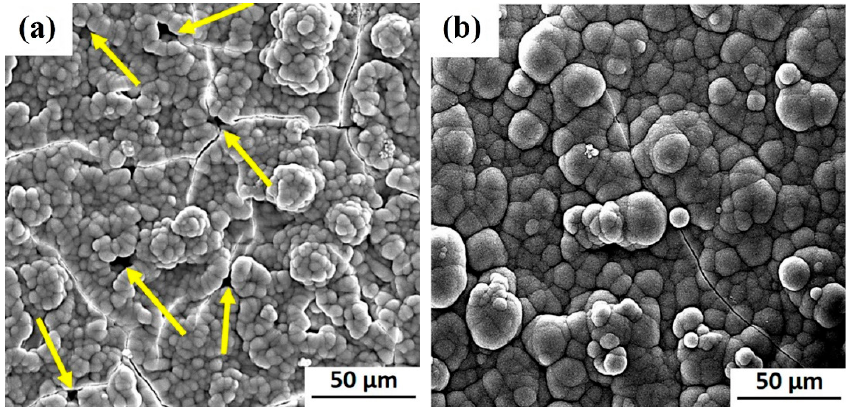
Figure 12. The surface morphology of formed apatite layer over the surface of ( a ) HAp and ( b ) HAp-100 µg mL − 1 graphene oxide (GO) coatings during the immersion in simulated body fluid (SBF). Yellow arrows highlight the discontinuity throughout the surface of the apatite layer formed over the pure HAp. Reprinted with permission from [264]. Copyright 2018